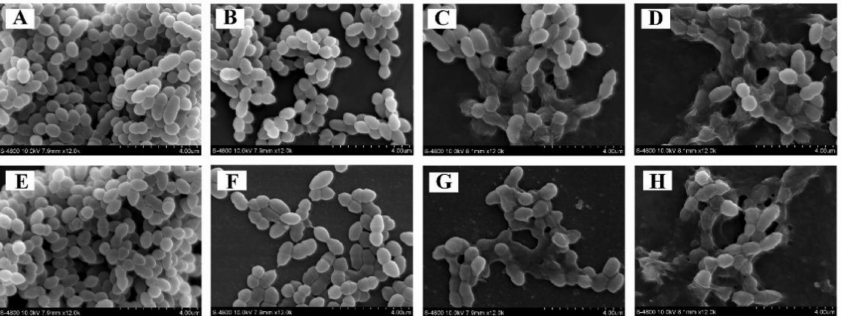
Figure 8. Observations of E. faecalis ATCC 29212 using field emission scanning electron microscopy ( × 12,000 magnification). Untreated for 1 ( A ) and 2 h ( E ). Treated with OEO at 1/4 MIC for 1 ( B ) and 2 h ( F ). Treated with OEO at 1/2 MIC for 1 ( C ) and 2 h ( G ). Treated with OEO at MIC for 1 ( D ) and 2 h ( H